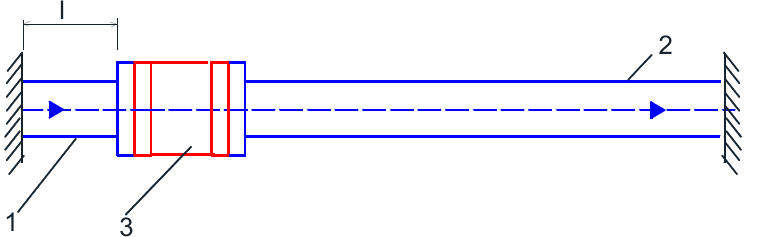
Figure 1. Experimental design. (1) High density polyethylene pipeline section (HDPE200) of l = 500 mm, 1000 mm and 1500 mm; (2) HDPE pipeline section of any length; and (3) the coupling piece (Flexseal Couplings SC200 reinforcement (Figure 2)).